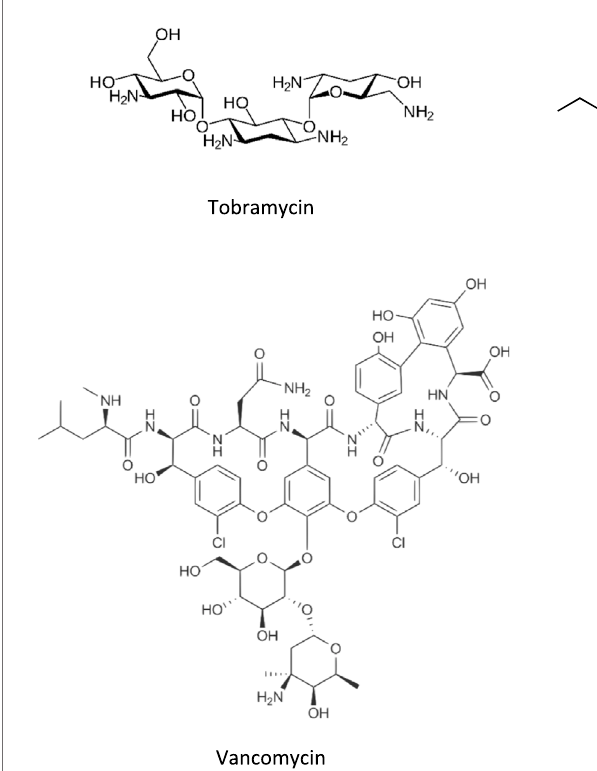
Frontiers in Toxicology |